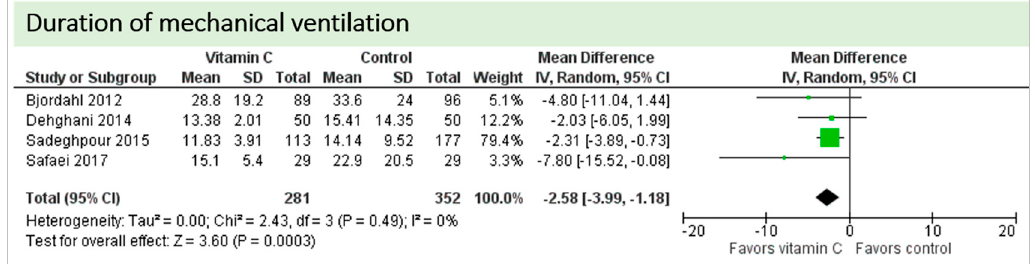
Figure 6. Duration of mechanical ventilation in hours.